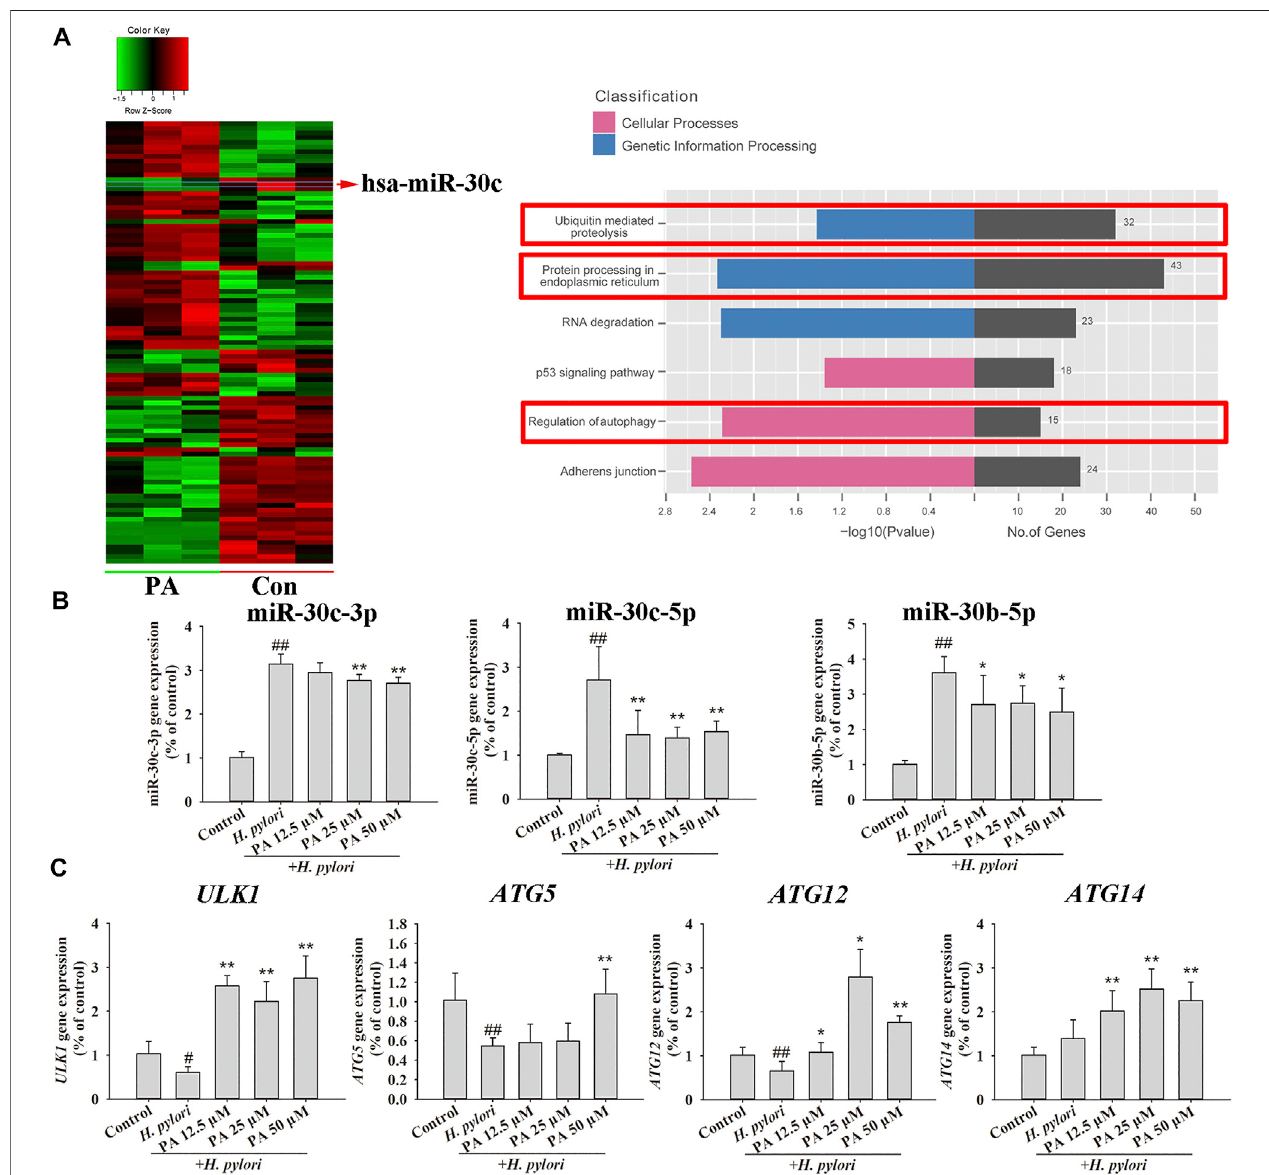
FIGURE7| MiRNAregulationbyPApromotedxenophagy. (A) MiRNAchipassaywasperformedonPA-treatedoruntreatedGES-1cells,andKEGGanalysiswas conducted to assess differentially expressed miRNAs ( n (cid:2) 3). (B) Quantitative gene expression results of miR-30c-3p, miR-30c-5p, and miR-30b-5p. (C) Quantitative gene expression results of ULK1 , ATG5 , ATG12 , and ATG14 . ## p < 0.01, compared with the control group. * p < 0.05, ** p < 0.01, compared with the H. pylori group, n (cid:2) 6.